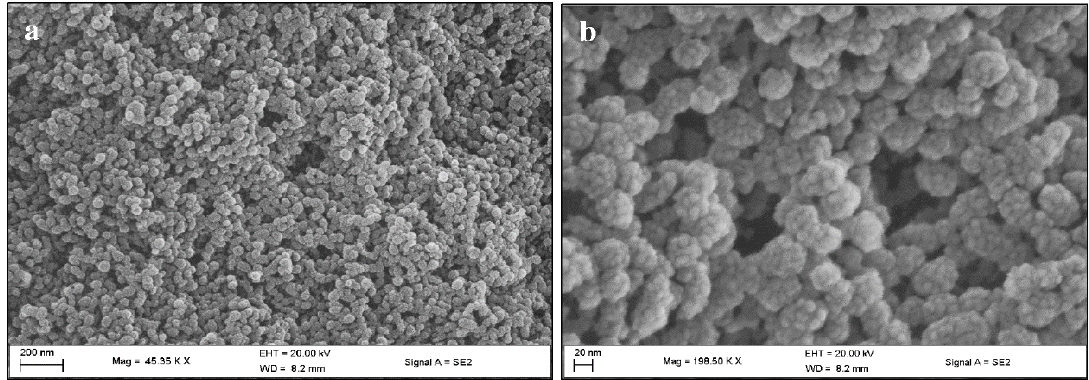
Figure 2. Scanning electron microscopy images of 5% PEG CHIT MSN: ( a ) scale bar = 200 nm and ( b ) scale bar = 20 nm.